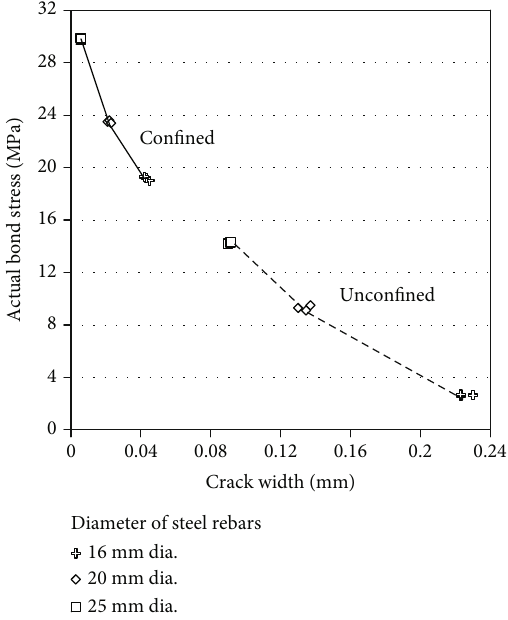
Figure 12: Correlation of crack width and bond stress.